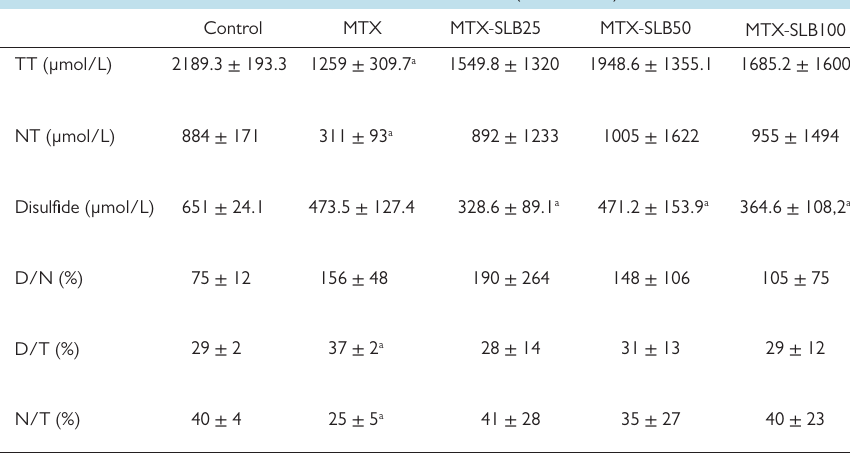
Table 2. Serum TT, NT, Disulfide, D/N, D/T, and N/T Levels (Mean ±